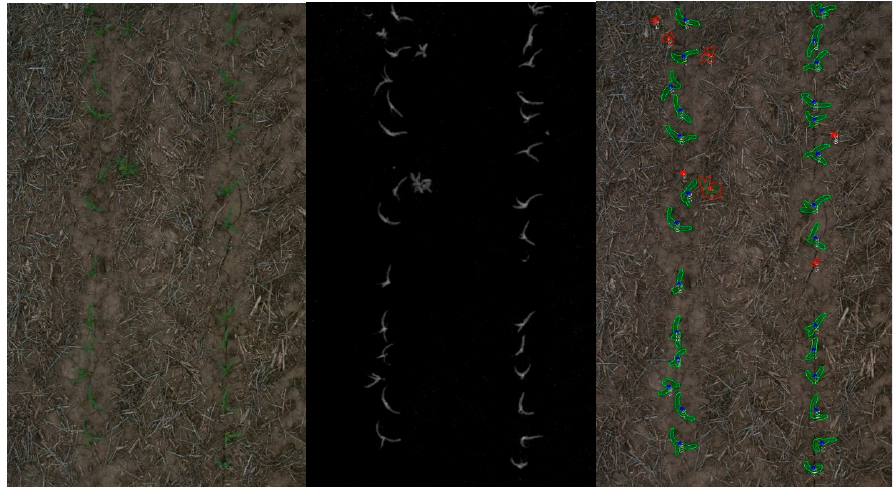
Figure 4. Left : RGB, center : ExG, right : classifier output on testing data in site 1, green contours: corn objects, red contours: non-corn objects.